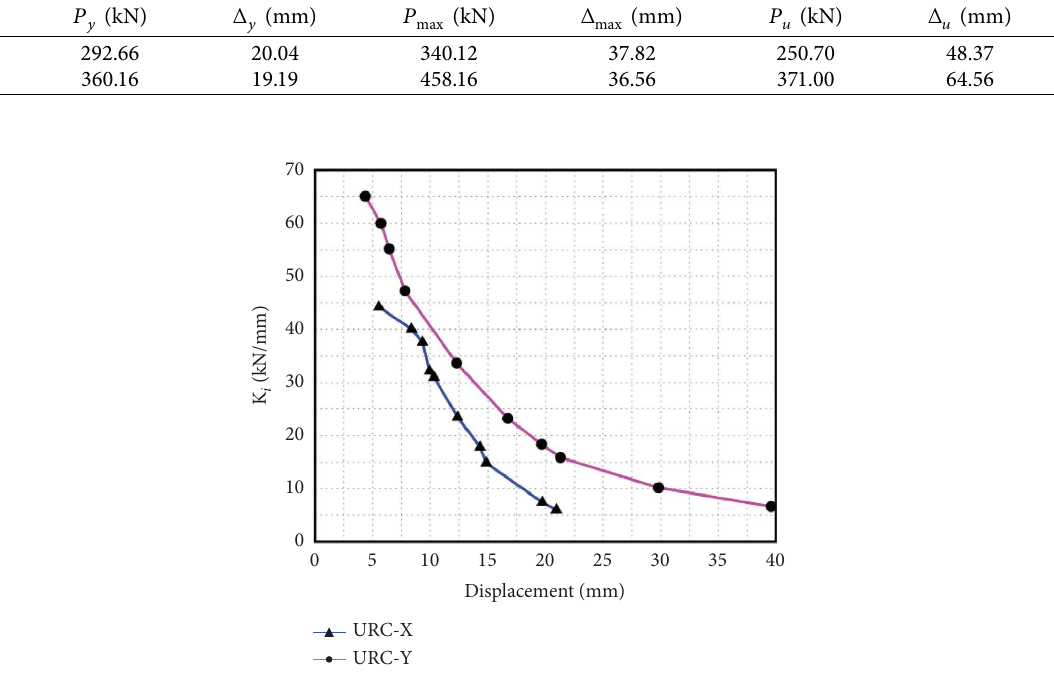
Figure 18: Overall stifness degradation